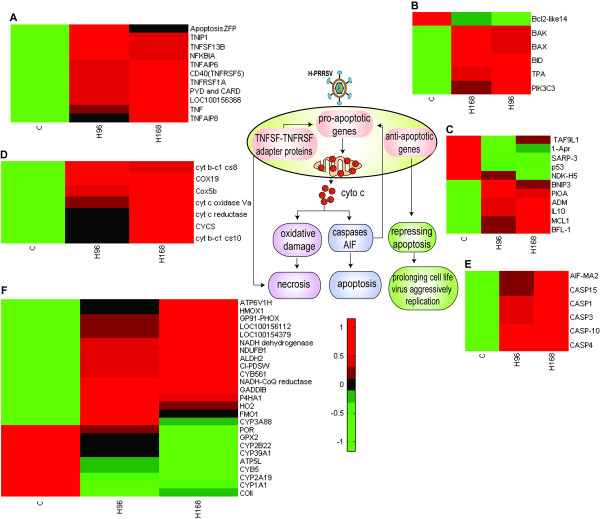
Schematic of cell death induced by H-PRRSV infection. The heat maps represent expression of selected DE genes associated with (A) tumor necrosis factor TNFSF, TNFRSF and adaptor proteins, (B) pro-apoptotic, (C) anti-apoptotic, (D) cytochrome c, (E) caspases and apoptosis-inducing factor (AIF), (F) electron transport and oxidative damage. Genes shown in red were up-regulated and those shown in green were down-regulated in infected pigs relative to C pigs (See Additional file 2 for full gene names).